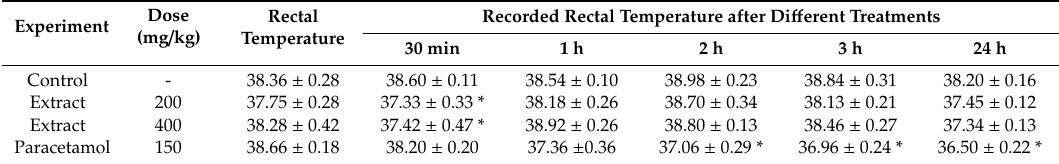
Table 3. Effect of H. campechianum flowers extract on pyrexia induced by brewer’s yeast in mice. Dose Experiment